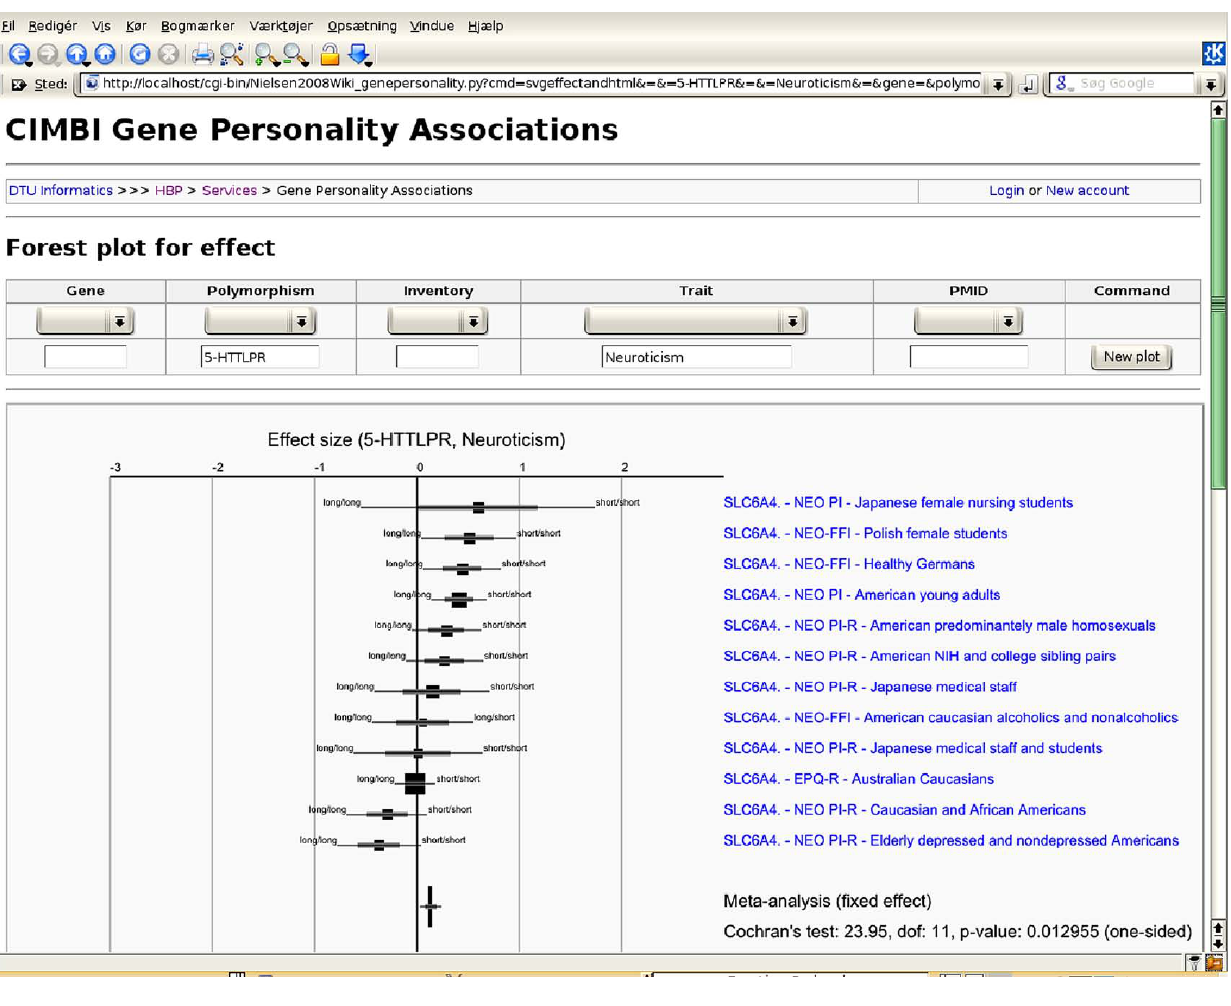
form. Recent work with image-based meta-analysis has shown the possibility of constructing sensible forest and funnel plots for functional neuroimaging data (Salimi-Khorshidi et al.,